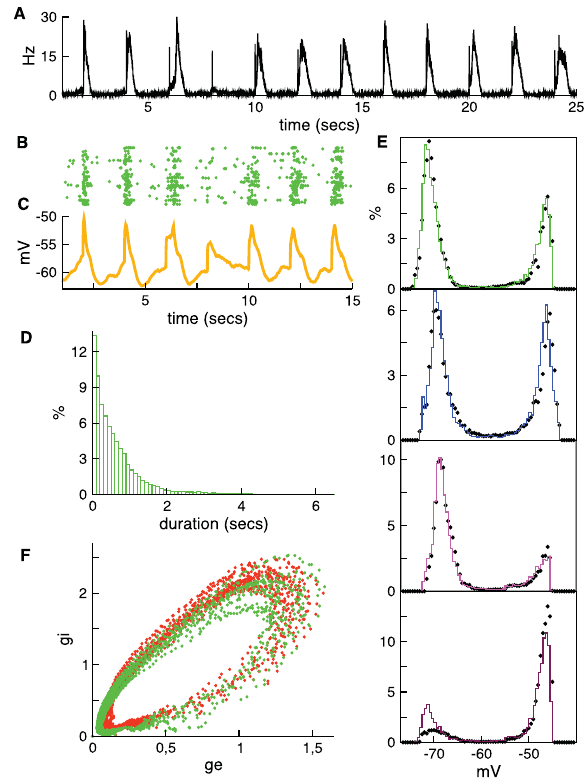
Figure 9. Periodic sensory stimulation of the silent network and charac- terization of the evoked slow fluctuations . (A) The population rate of the silent network when it is minimally stimulated every 2seconds. During the 25seconds of this simulation the stimulus failed to evoke an up state only once (at t=8seconds). (B) Raster for the first 15seconds of the simulation. (C) Average potential. (D) Histogram of the durations of the up states. (E) Membrane potential histograms for the same four neurons shown previously. The black dots show data from Figure 3 . (F) Evolution of the average conduc- tances is indicated by the green dots. For comparison, the red dots are data from Figure 4B